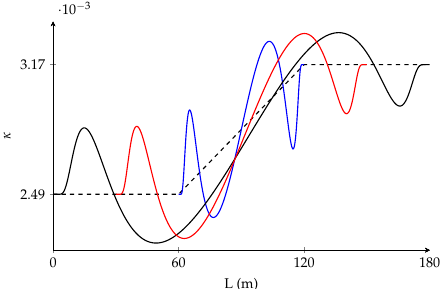
Figure12. Curvatureplotsoftheclothoidwithpartsofthecircularsegments(dashed)anddefault Figure 12. Curvature plots of the clothoid with parts of the circular segments (dashed) and default ERB-functionblendingsplines,withlocalarccurves,forthethreeentrypoints [ p 1 , q 1 ] (blue), [ p 2 , q 2 ] (red),and [ p 3 , q 3 ] (black). ERB-function blending splines, with local arc curves, for the three entry points [ p 1 , q 1 ] (blue), [ p 2 , q 2 ] Comparedtotheclothoid’slinearcurvature,theblendingsplineshavefiveinflectionpointsin 232 (red), and [ p 3 , q 3 ] their curvature graphs, which is not optimal and should be attempted smoothed out. A positive 233 characteristics of the blending splines is that they go smoothly towards the end points, where the 234 clothoid has a discontinuity in connection to the constant curvature of the adjacent segments, as 235 described in Figure 11. This leads us to believe that the blending spline, at least with a default 236 ERB-function, satisfies additional criteria (4 and 5 presented in Section 3.3) when compared to the 237 clothoid. To test our hypothesis, graphs of the first and second derivatives of the curvature for the 238 blending spline in [ p 3 , q 3 ] are printed. Since the behaviour is fairly familiar for the three blending 239 splinesintheendpointsonlyoneischecked. TheresultcanbeseeninFigure13,wheretheconstant 240 first derivative of the clothoid’s curvature (dashed) is plotted against the first (solid) and second 241 (dotted)derivativesoftheblendingspline’scurvature. Fromthefigureitcanbeobservedthatthefirst 242